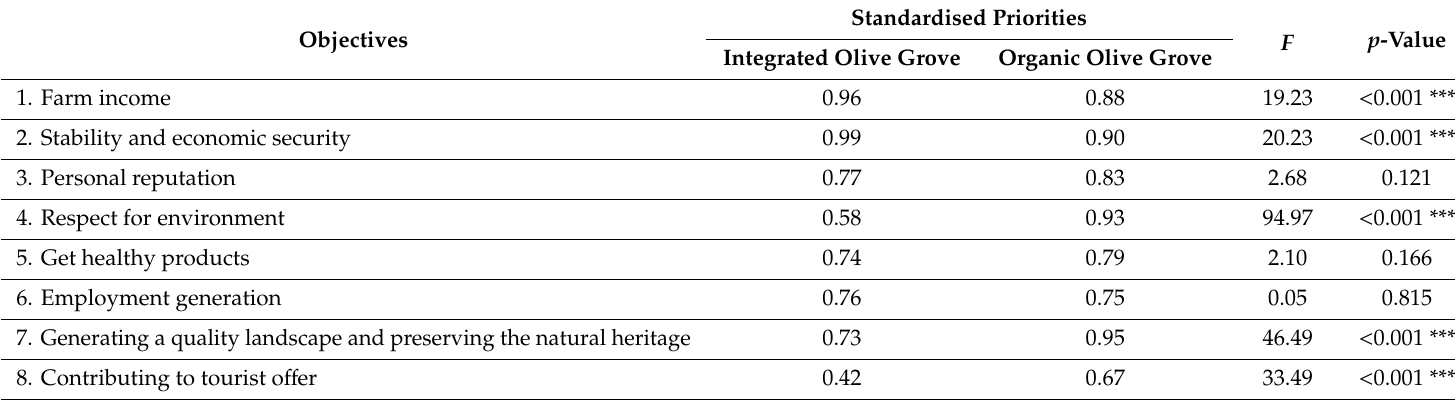
Table 4. Standardised priorities for the objectives in the integrated and organic management of the olive groves in the Estepa region in all erosive states assessed. Statistical values of F (Kruskal–Wallis test), and p -values; significant ( < 0.05 *), very significant ( < 0.01 **), and highly significant ( < 0.001 ***) are shown.